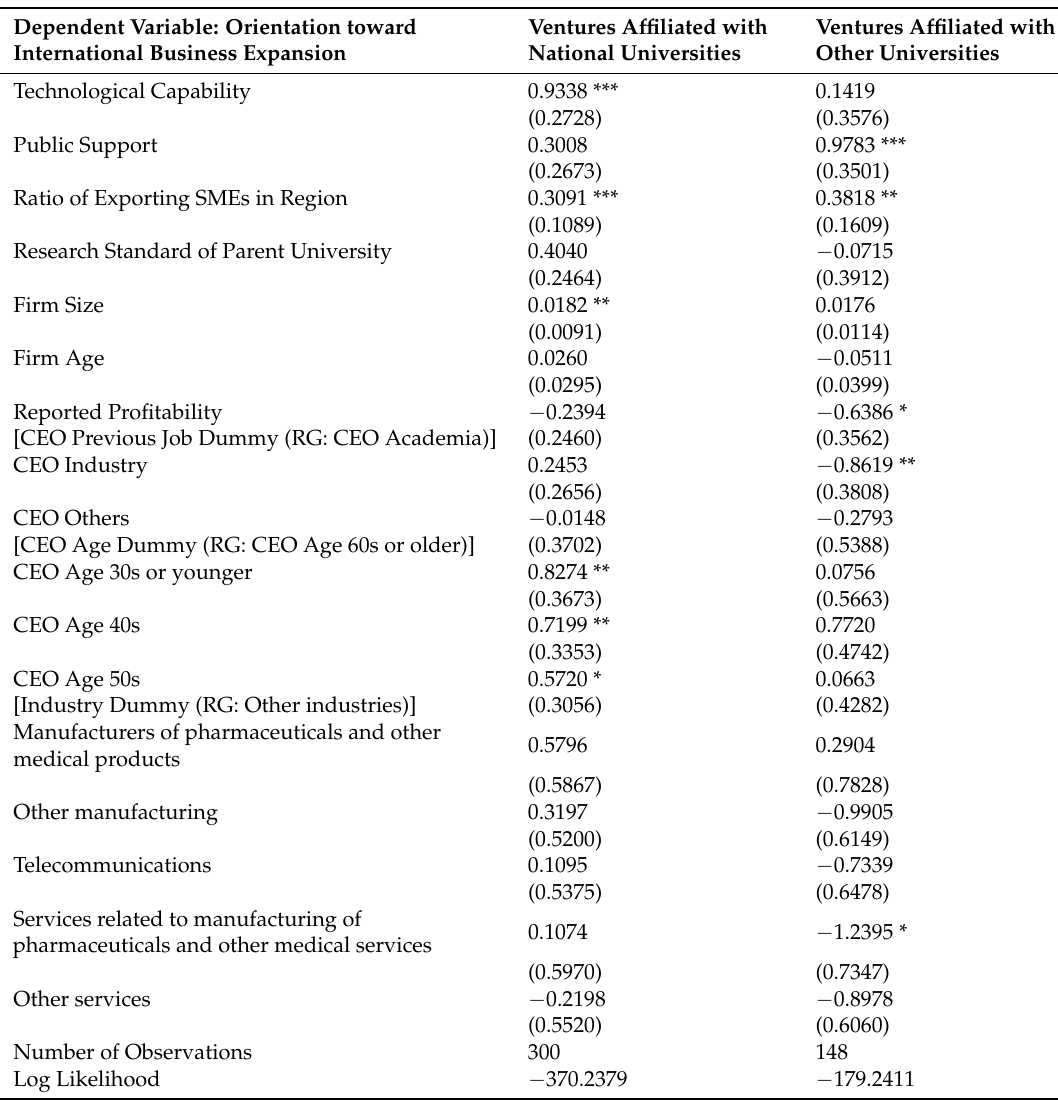
Table 5. Determinants of orientation toward international business expansion: comparison between national and other